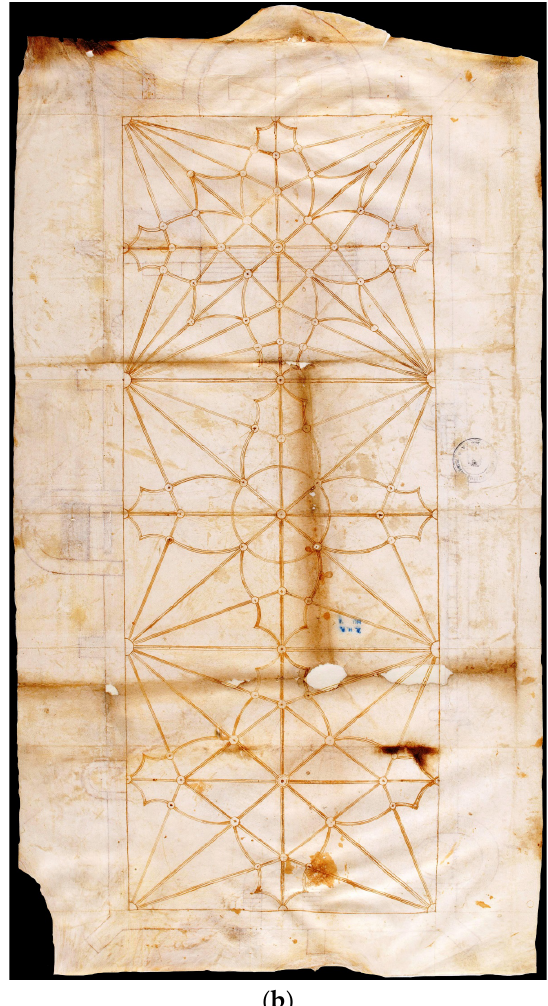
Figure 7. Project of the parish church of Siétamo (Huesca) [A.H.P.HU., ES/AHPHU-012032/1]. © Archivo Histórico Provincial de Huesca. Figure 7. ( a , b ) Project of the parish church of Si é tamo (Huesca) [A.H.P.HU., ES/AHPHU-012032/1]. © Archivo Hist ó rico Provincial de